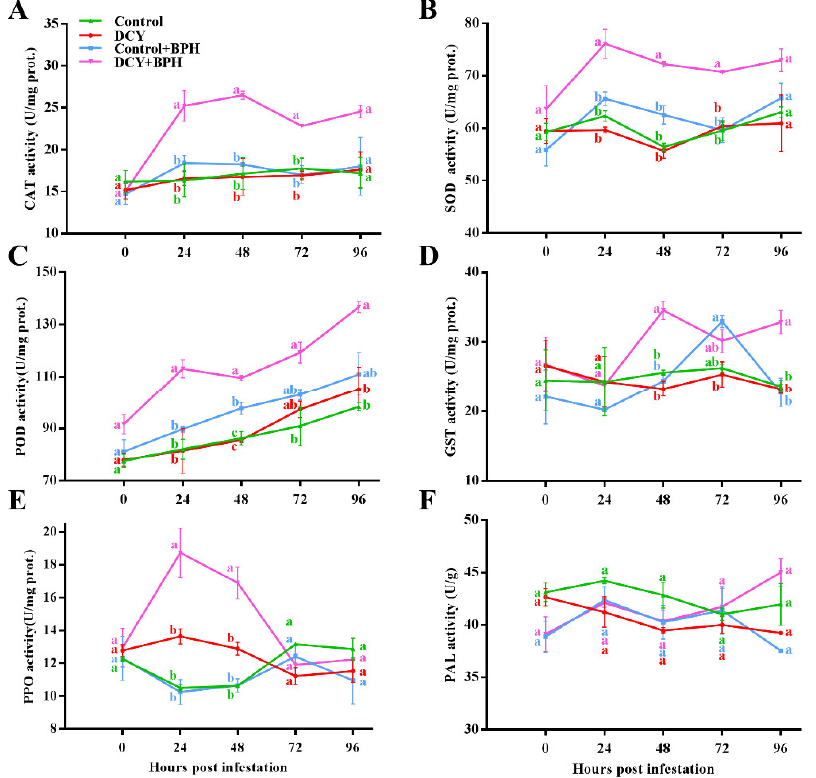
Figure 1. Changes in defense-related enzyme activity in rice sheaths’ responses to DCY treatment and BPH infestation: ( A ) CAT, ( B ) SOD, ( C ) POD, ( D ) GST, ( E ) PPO, and ( F ) PAL. Data represent means ± standard error of three replicates. Different letters at a certain time point post-BPH infesta- tion indicate significant differences ( p < 0.05, Tukey’s HSD test).